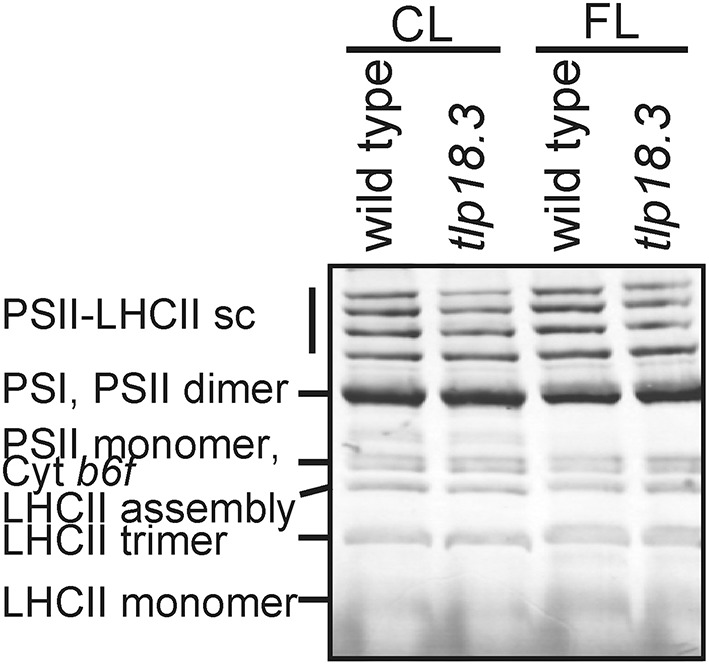
Accumulation of thylakoid protein complexes in wild-type and tlp18.3 plants. Plants were grown in 8 h light regime either in a photon flux density of 120 μmol photons m−2 s−1 (constant growth light; CL) or 50 μmol photons m−2s−1 for 5 min and 500 μmol μmol photons m−2s−1 for 1 min (FL, fluctuating light). sc. supercomplex. A representative example from three independent biological replications is shown.